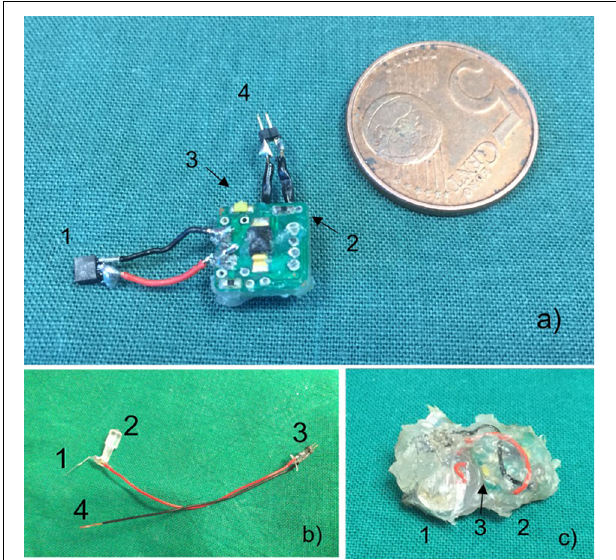
FIGURE 1 | (a) Stimulator in comparison to 5 eurocent mint. Connection for electrode (1), magnetic reed contact (2), white LED for running control (3), connection to batteries (4). (b) Stimulation electrode with electrode (1), removable positioning aid (2), male connector (3), and connection to ground (4). (c) Coated stimulator device comprised of batteries (1), circuit board (2), and white LED (3).